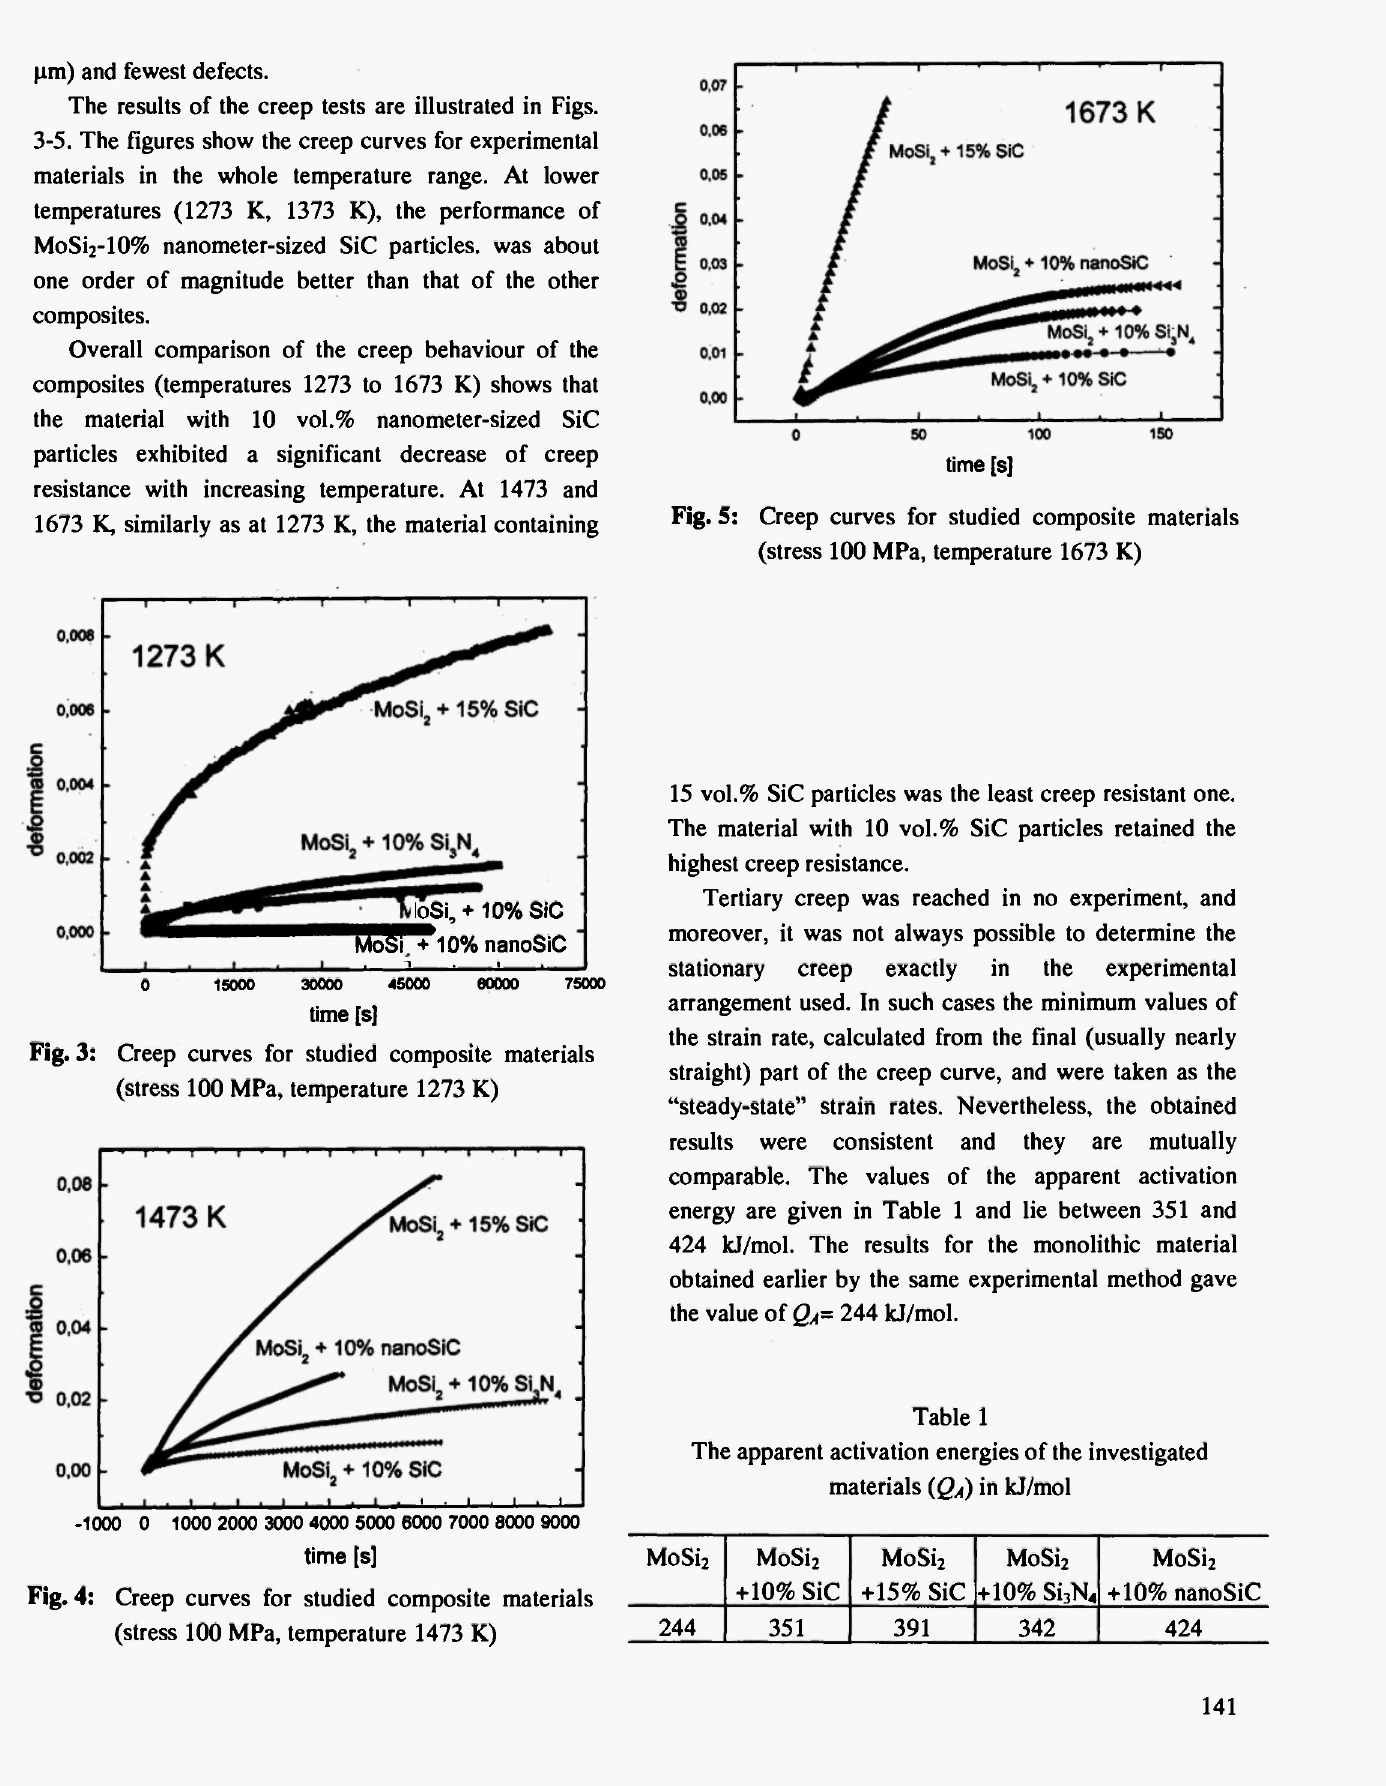
Fig. 5: Creep curves for studied composite materials